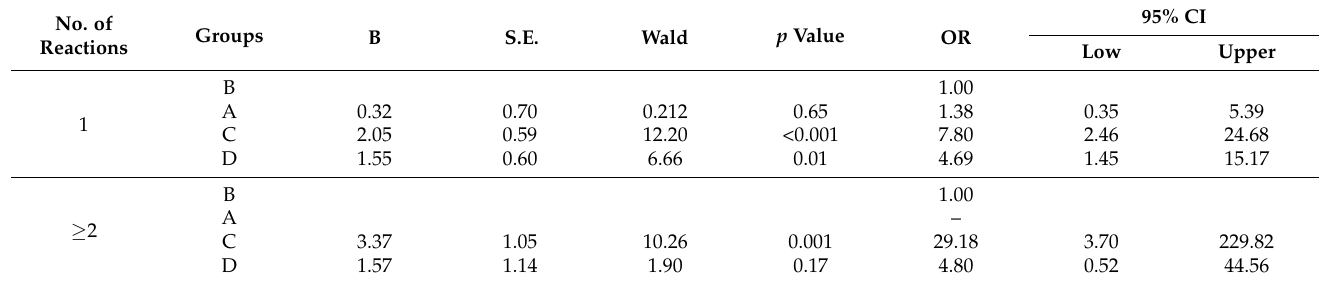
Table 6. Odds ratios for risk of number of reactions relative to those without any reaction, multinomial logistic regression